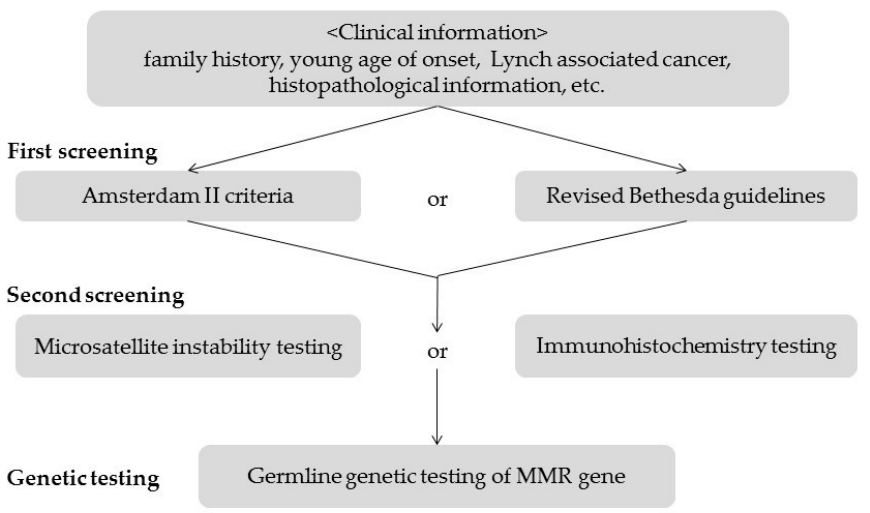
Figure 8. Screening for Lynch syndrome in the Japanese Clinical Practice Guidelines for Hereditary Colorectal Cancer.